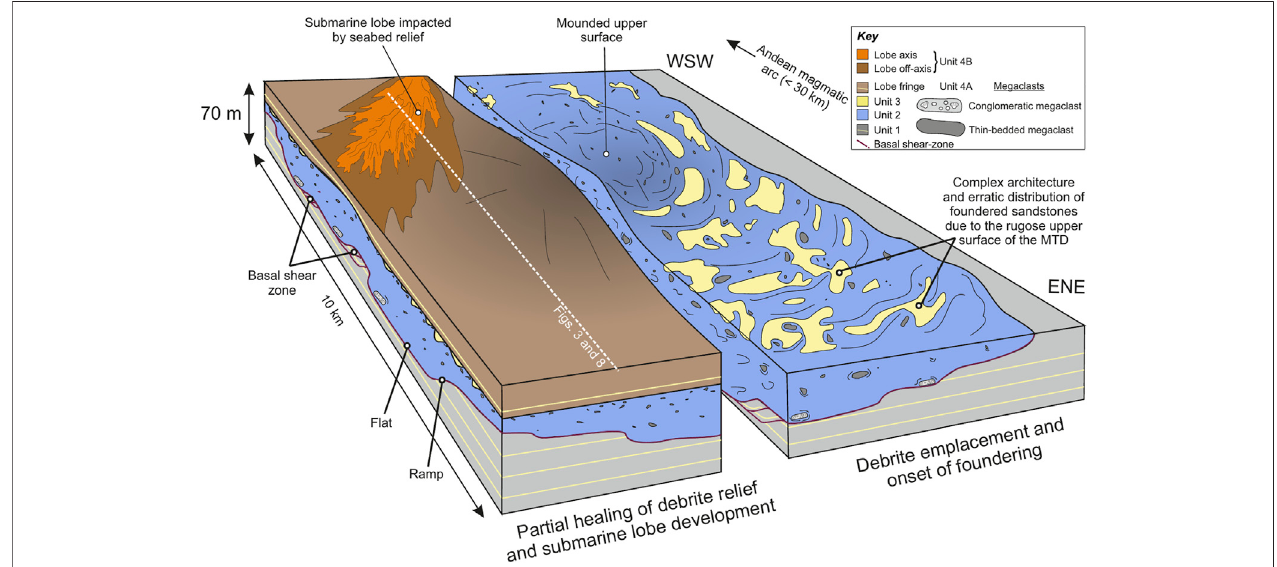
FIGURE10| Down-dip oriented schematic diagram illustrating the relief created by thedebrite and theimpact on younger sand-rich units. Foundered sandstones fi ll the small-scale rugosity, leaving the kilometre-scale accommodation under fi lled. The submarine gravity fl ows are de fl ected by long-lived subtle debrite-related relief (right block) . Partial healing and drapping of the debrite with the progradation of submarine lobes, which are gently impacted by the long-lived inherited relief. Note the white dashed line representing the correlation shown in Panels 3 , 8 .